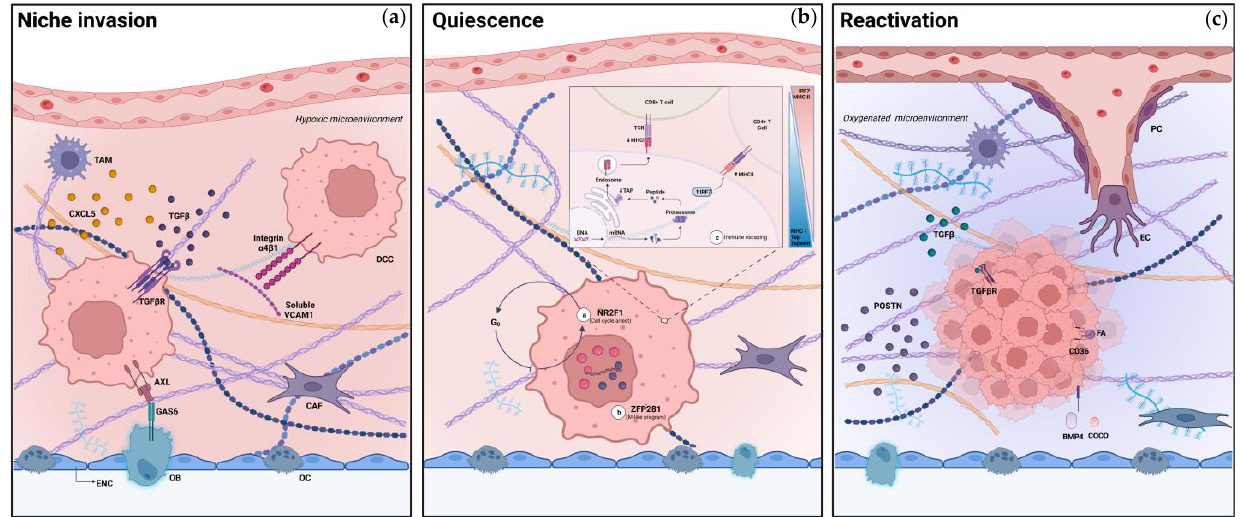
Figure 1. The life cycle of dormant cancer cells and their interactions with the niche ecosystem. An endosteal-perivascular niche is schematically represented above. The endosteal surface is placed below (cell lining below, ENC: endosteal cell or bone lining cell, OC: osteoclast, OB: osteoblast). Extracellular matrix (ECM) is the pink or blue space in the middle (pink: hypoxic environment, blue: oxygenated environment, fibrils: ECM protein structure, CAF: cancer-associated fibroblast, TAM: tumor-associated macrophage, DCC: dormant cancer cells). Blood vessels are above in the figure (PC: pericyte, EC: endothelial cell). ( a ) Niche invasion: DCCs anchor to ECM protein structure, es- tablish a hypoxic microenvironment and interact with niche-resident cells that stimulate survival signals in the DCCs. ( b ) Quiescence: DCCs upregulate transcription factors that maintain a mesen- chymal, quiescent phenotype and inhibit immune response with a direct interplay with T-lympho- cytes and other immune-competent cells. ( c ) Reactivation: at some point, soluble factors secreted by the niche-resident cells and immune-competent cells and signals stimulated directly by DCCs in- duce angiogenesis and promitotic signals with subsequent reactivation of DCCs and manifestation as clinically detectable metastasis. (TCR: T-cell receptor, MHC: major histocompatibility complex, IRF7: interferon regulatory factor 7, TAP: transporter associated with antigen processing, CXCL5: C-X-C motif chemokine ligand 5, TGFβ: t ransforming growth factor β, GAS6: growth arrest-specific 6, NR2F1: nuclear receptor subfamily 2 group F member 1, ZFP281: zinc finger protein 281, POSTN: periostin, FA: fatty acid, BMP4: bone morphogenetic protein 4